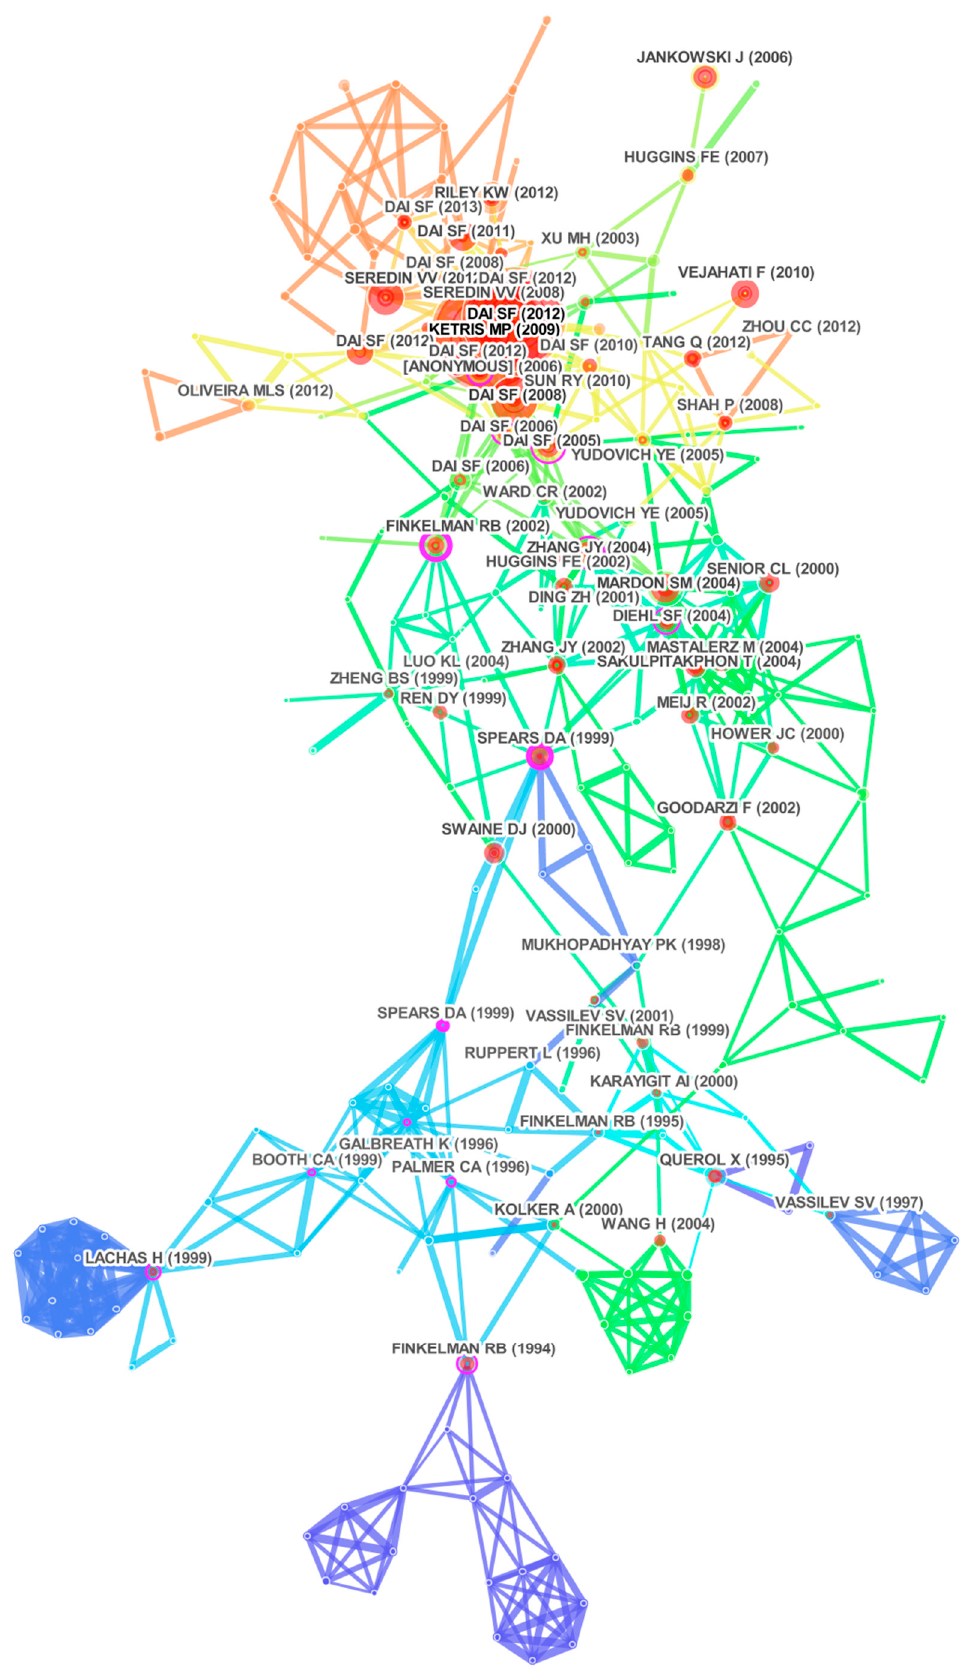
Figure 10. SNA (social network analysis) of highly cited publications of trace elements in coal and ash during 1999–2017.